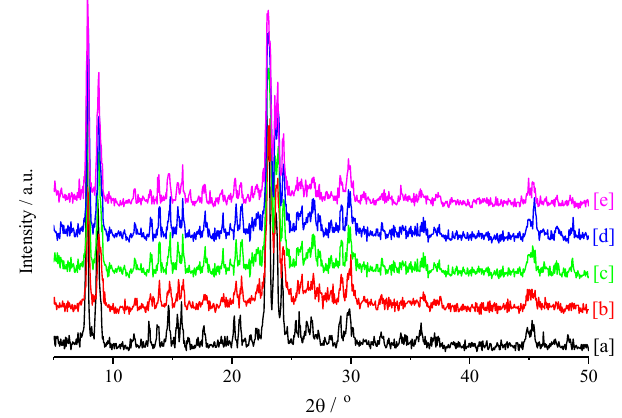
Figure 1. XRD patterns for ( a ) ZSM ‐ 5, ( b ) ZSM ‐ 5 ‐ Na, ( c ) ZSM ‐ 5 ‐ C, ( d ) ZSM ‐ 5 ‐ T and ( e ) ZSM ‐ 5 ‐ CT. Table 2. The crystallite size and crystallinity of treated and untreated zeolite catalysts. Catalysts Crystallite Size (nm) Crystallinity (%) ZSM ‐ 5